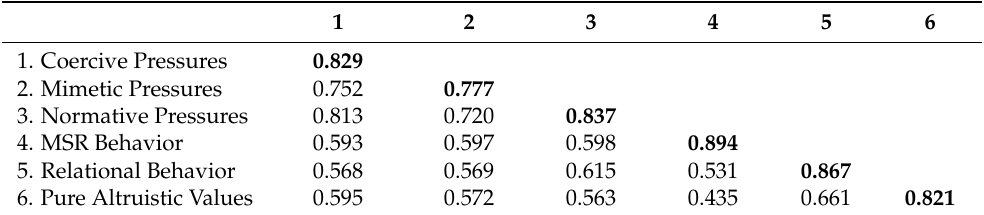
Table 4. Correlations of Latent Variables and Evidence of Discriminant Validity.